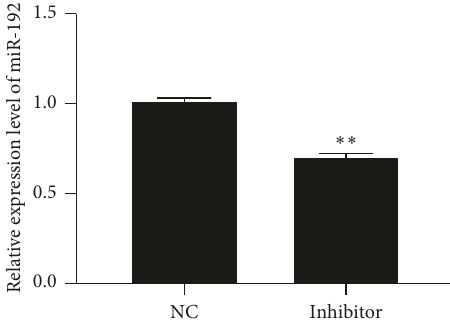
Figure 3: Effects of miR-192 on malignant behavior of H125 cells. ∗∗ P < 0 . 01 vs the NC